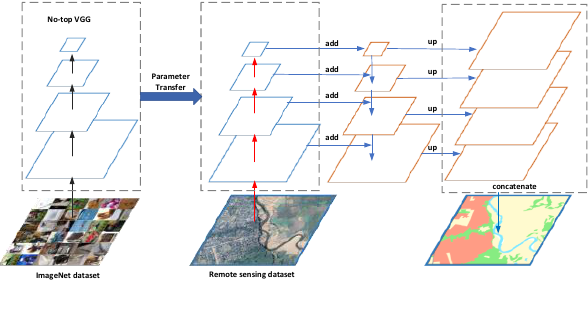
Figure 2. FPN-VGG